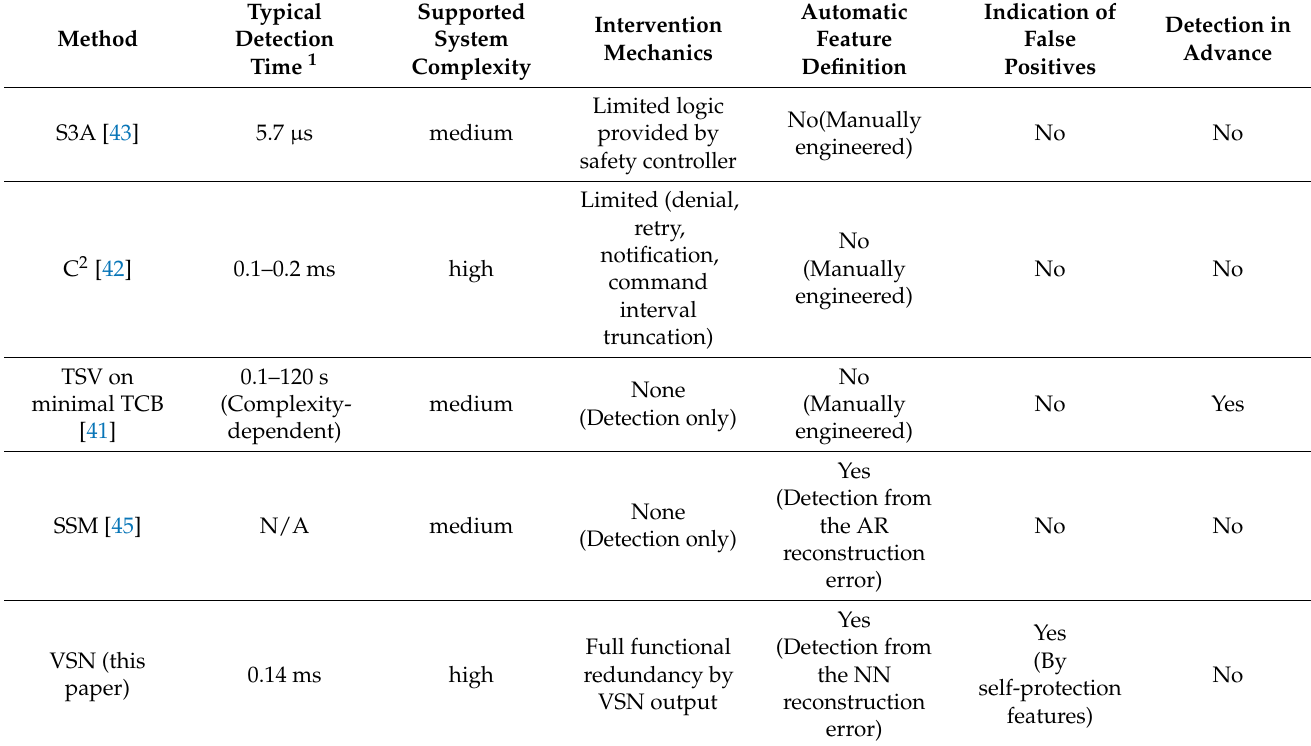
Table 1. Comparison of related methods.